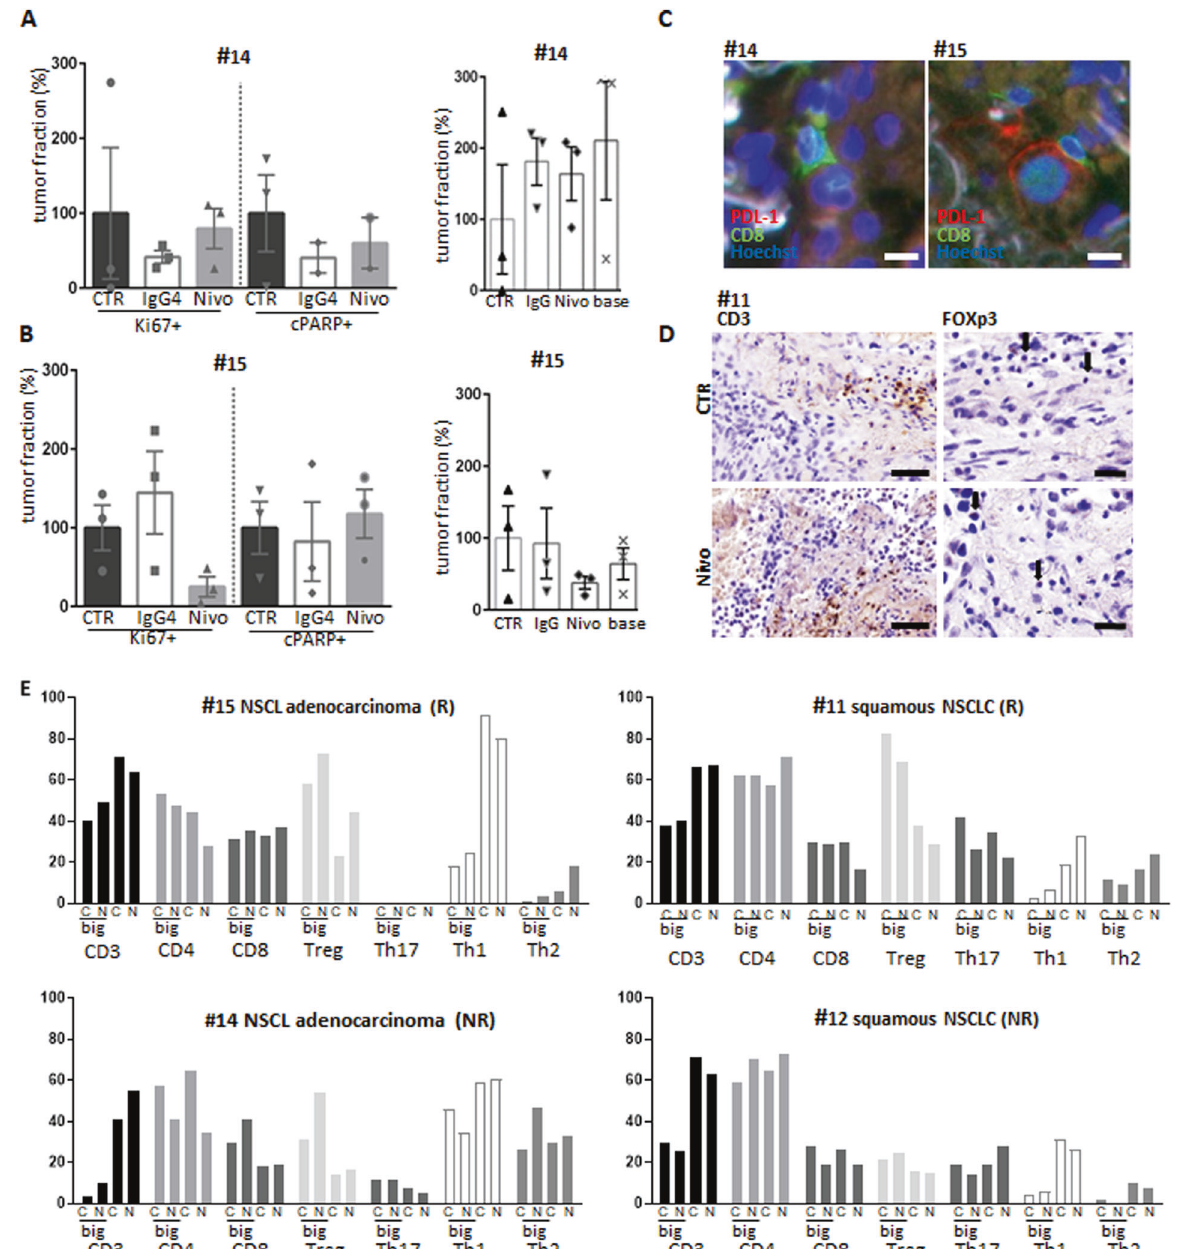
Fig. 4 Altered T-cell repertoire after nivolumab treatment in NSCLC. A, B Tissue specimens #14 ( A ) and #15 ( B ) were cultured ex vivo under control condition or upon addition of nivolumab or its isotype control, an IgG4 Ab. After 5 days of treatment the tissue were stained for Ki67 or cleaved PARP to evaluate the percentage of proliferating or apoptotic cells as well as for the total fraction of tumor within the tissue. Kruskal – Wallis test was performed. C Representative staining of tissue from #14 and #15 treated with nivolumab and stained with PD-L1 (red) and CD8 (green), Hoechst, blue; background, white. Bar = 20 µm. D Representative staining of #11 with CD3 (left) or FoxP3 (right) in control (top) and nivolumab (bottom) treated conditions. CD3, bar = 50 µm, FoxP3, bar = 20 µm. E Single-cell suspension obtained from the tissue specimens, cultured for 5 days in the presence or absence of nivolumab, were evaluated by fl ow cytometry. Shown are the percentages of the different T-cell populations as obtained with the gating strategy shown in supplementary Fig. 1. NR nonresponder, R